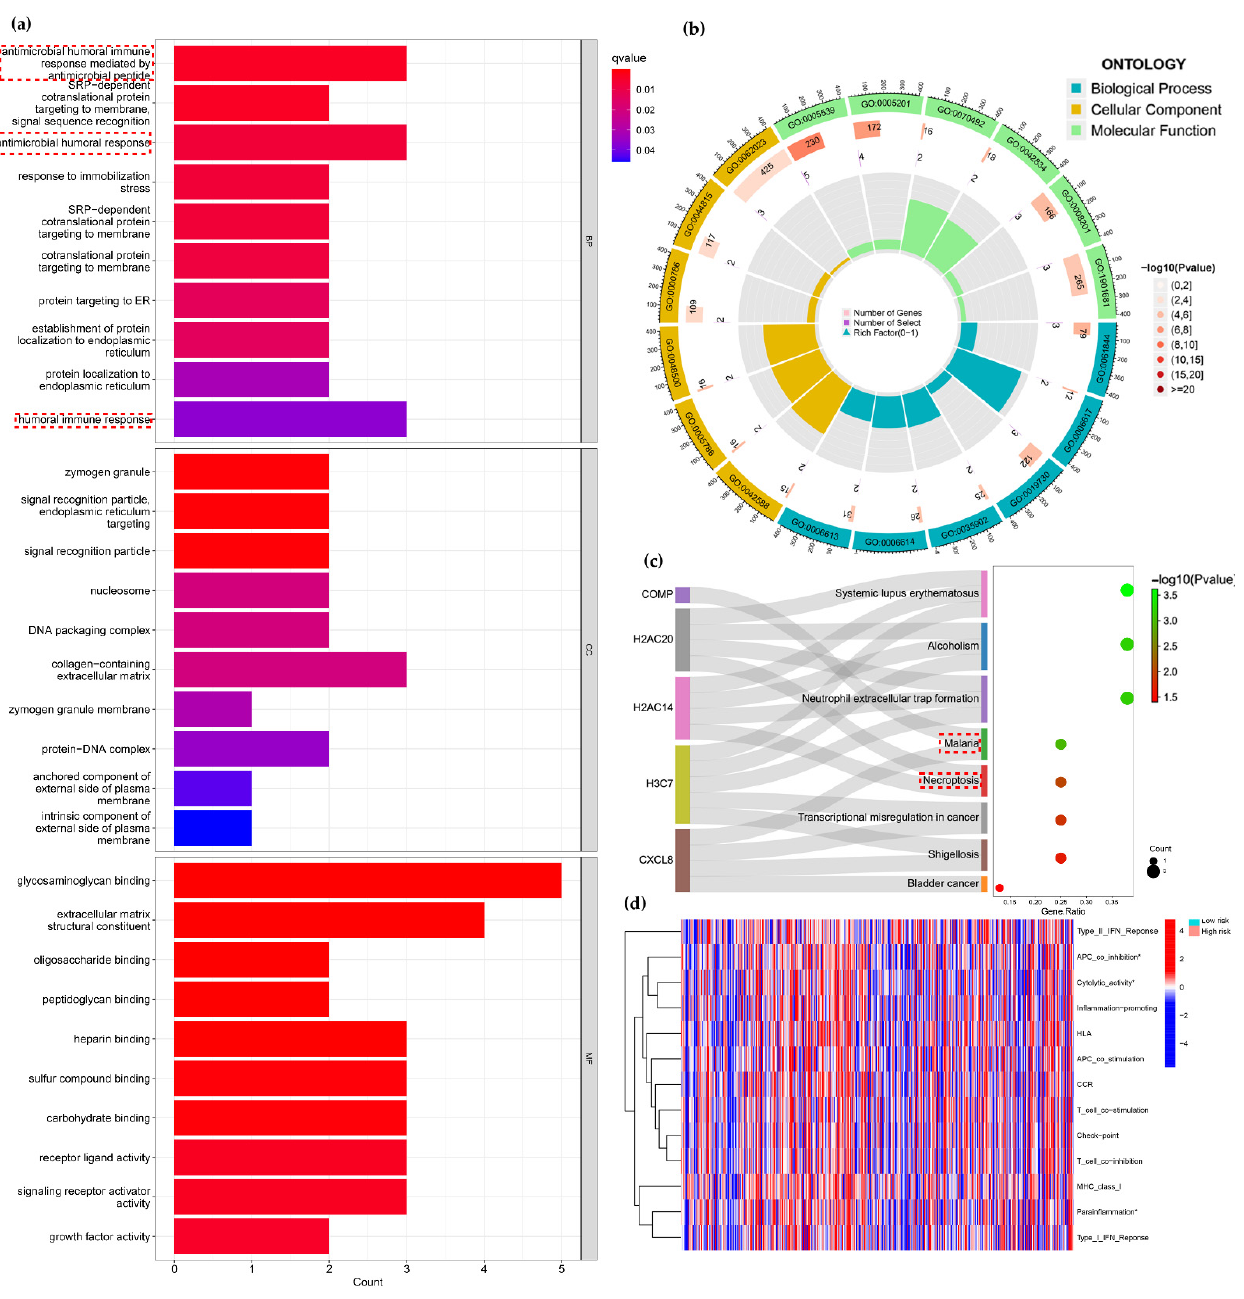
Figure 5. KEGG analysis and immune-related functional analysis. ( a , b ) GO enrichment analysis of risk differential genes. ( c ) KEGG analysis of risk differential genes. ( d ) Analysis of immune-related functions in high-risk and low-risk subgroups (* p < 0.05).